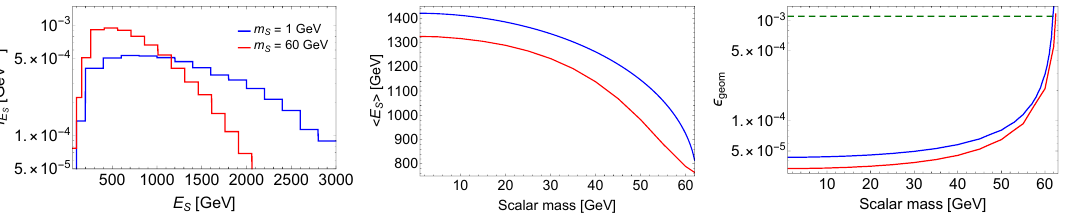
Figure 7 . Properties of dark scalars (cid:13)ying into the FASER 2 decay volume. Left panel : energy dN S spectrum of scalars f E = 1 for di(cid:11)erent masses. Middle panel : The average energy of N S dE S S scalars. Right panel : The geometric acceptance (cid:15) geom versus the scalar mass. In the middle and right panels, the blue lines denote analytic estimates obtained using the Higgs p L spectrum (right panel in (cid:12)gure 3), while the red lines show the results of more accurate estimates including the p T distribution of the Higgs bosons (see appendix